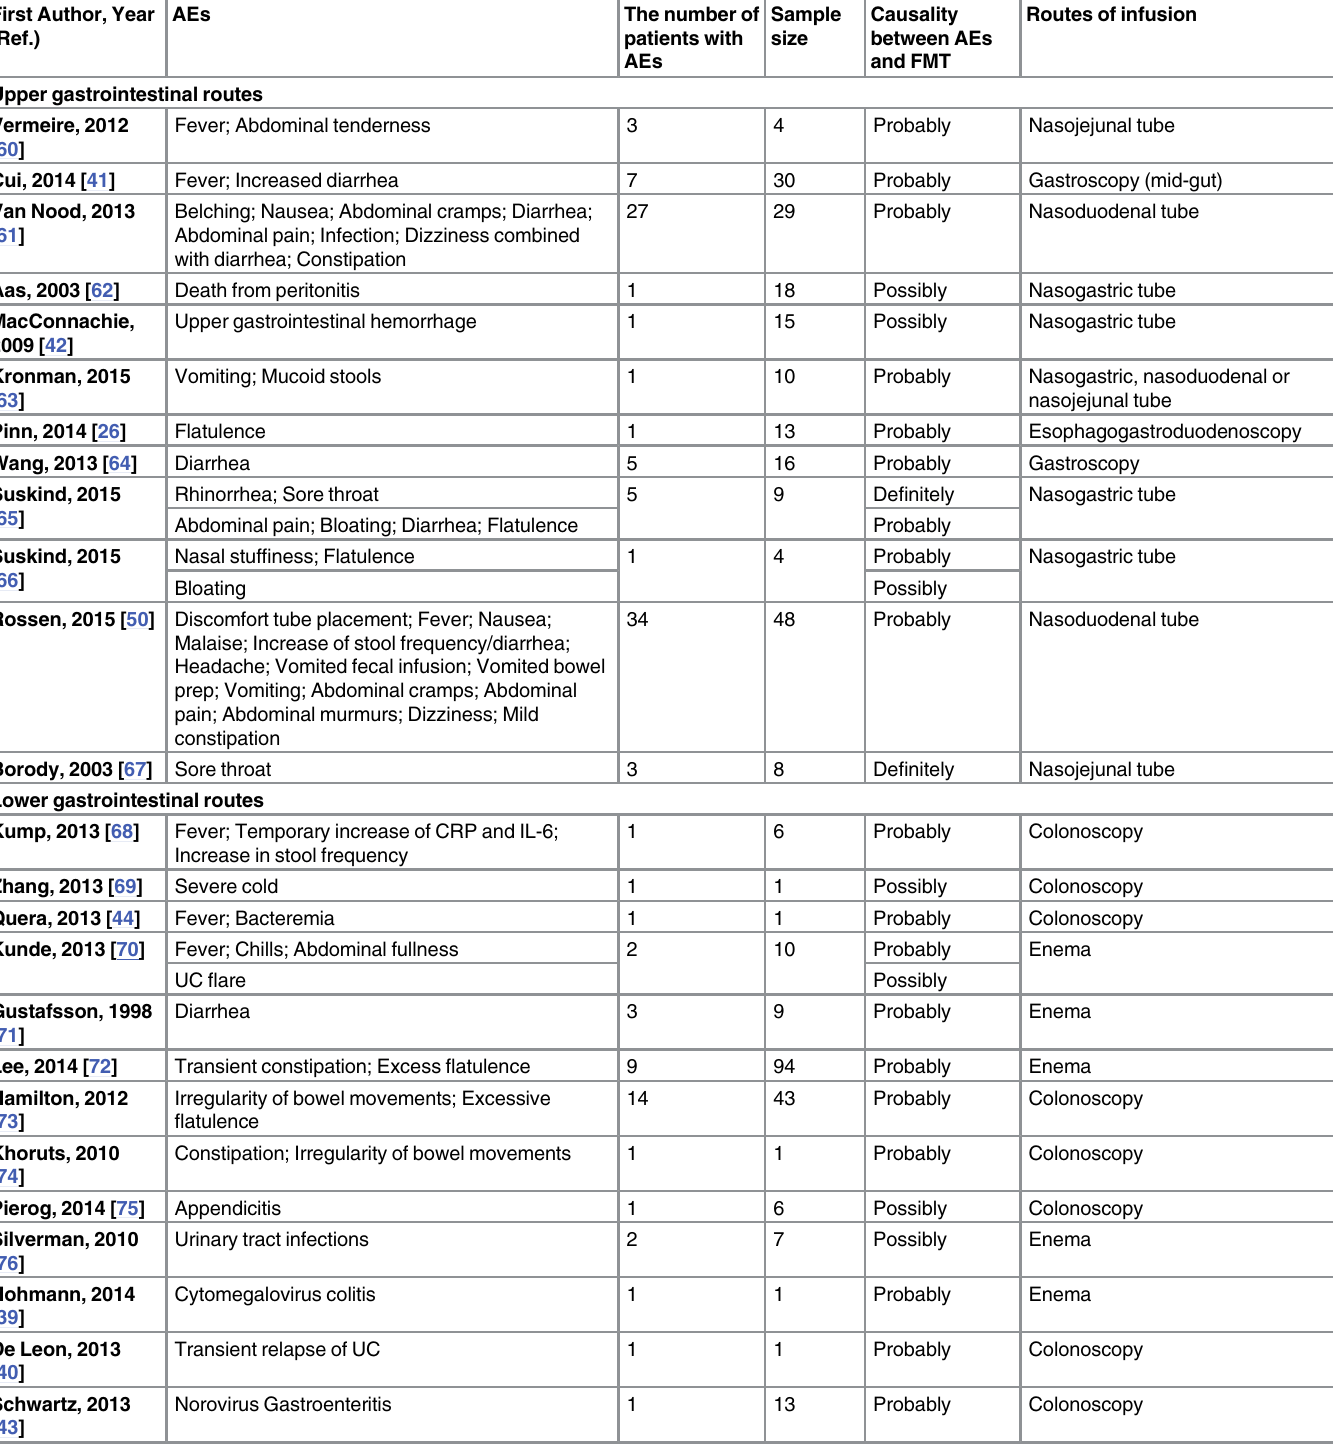
Table 2. Attributable adverse events are grouped by route of administration (Upper gastrointestinal routes; Lower gastrointestinal routes). First Author, Year